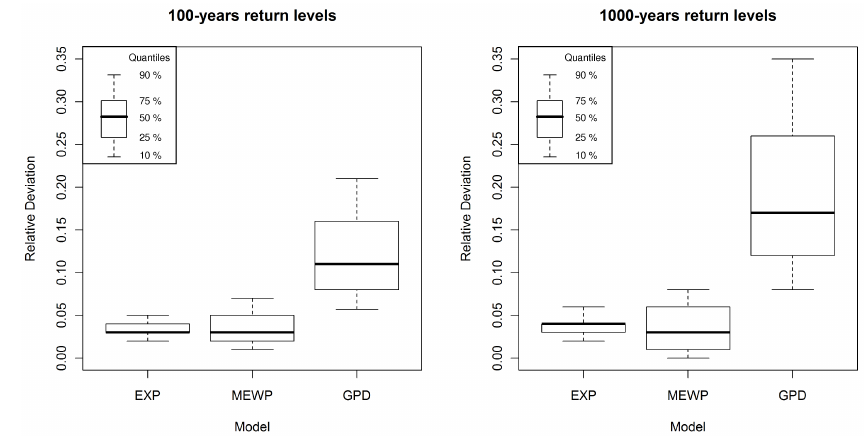
Fig. 11. Relative deviation between two estimations of the100-years (left) and 1000-years (right) return levels. For each model (EXP, MEWP and GP distribution) the two estimations are computed on the “season-at-risk”, with and without the observed maximum. The box plots show the spread of the results for the 478 rain gauges.